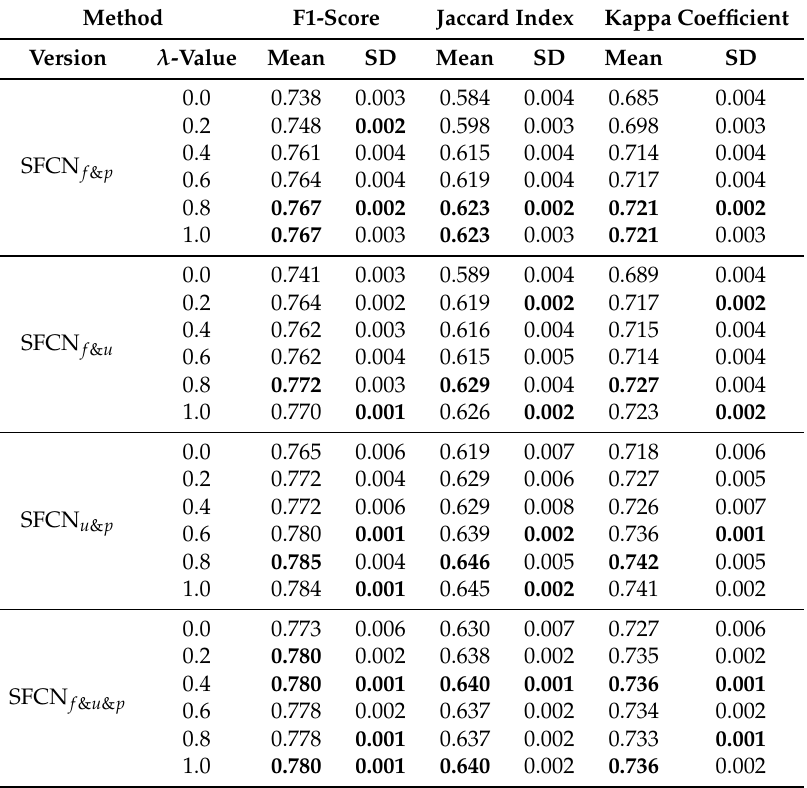
Table 3. Table of model performances of four SFCNs under lambda values in [0.0, 0.2, 0.4, 0.6, 0.8, 1.0].The x and y axes represent the models and their corresponding values, respectively. ( b ) Table of mean value and standard deviation (SD) of performance comparisons among these methods. For each evaluation metric, the highest mean values and lowest SD are highlighted in bold